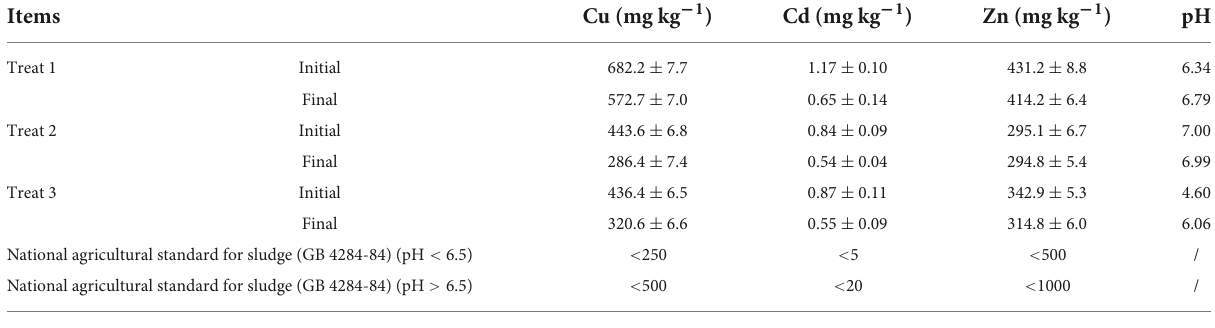
TABLE 2 Changes of heavy metals in municipal sludge composting before and after treatment.